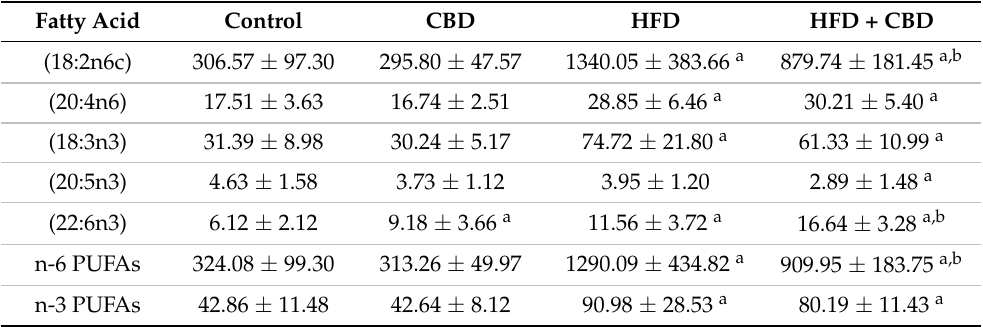
Table 5. Polyunsaturated fatty acids (PUFA) content in the TAG fraction (nmol/g of wet tissue) in white gastrocnemius muscle in the control (standard diet) and high-fat diet (HFD) groups after two-week cannabidiol (CBD) treatment.